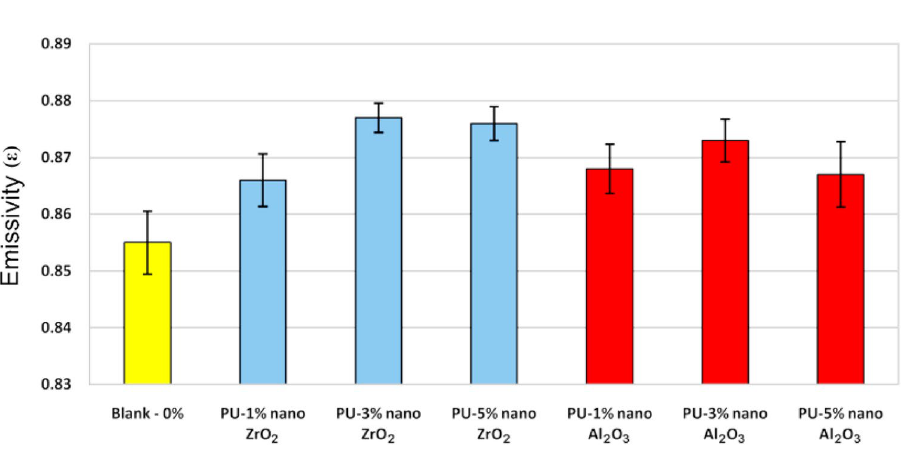
Figure 2. Emissivity coefficient with standard deviation for polyurethane nanocomposite